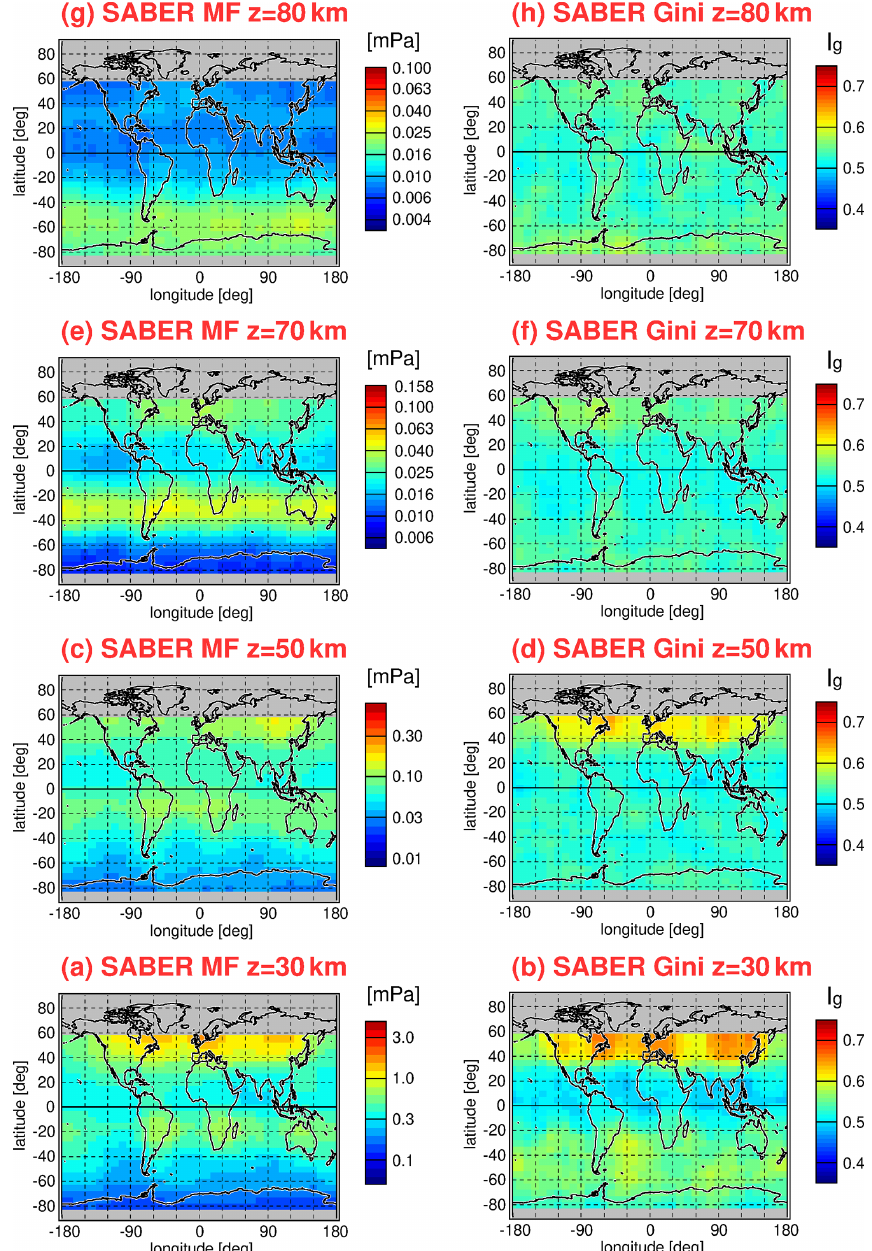
Figure 18. Same as Fig. 17 but for the calendar month of December.